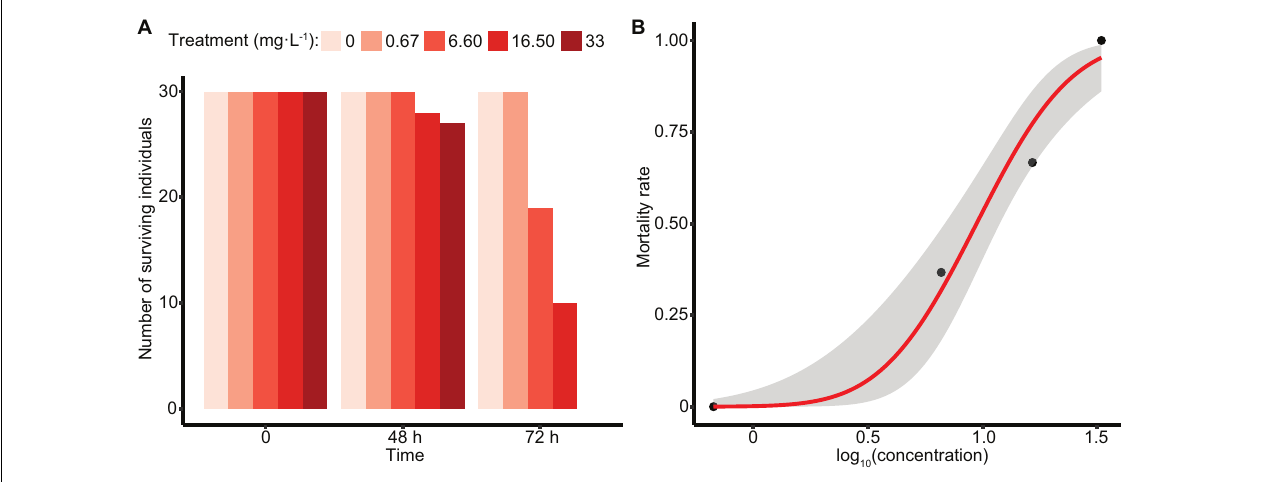
FIGURE 1 | Survival of M. manhattensis (A) at 48 and 72 h (mg · L − 1 as N); (B) concentration-response curve at 72 h in the ammonia acute toxicity test. The concentration-response was determined by plotting the Probit transformed percent mortality against log concentration (mg · L − 1 as N total ammonia). The gray area indicates the 95% confidence